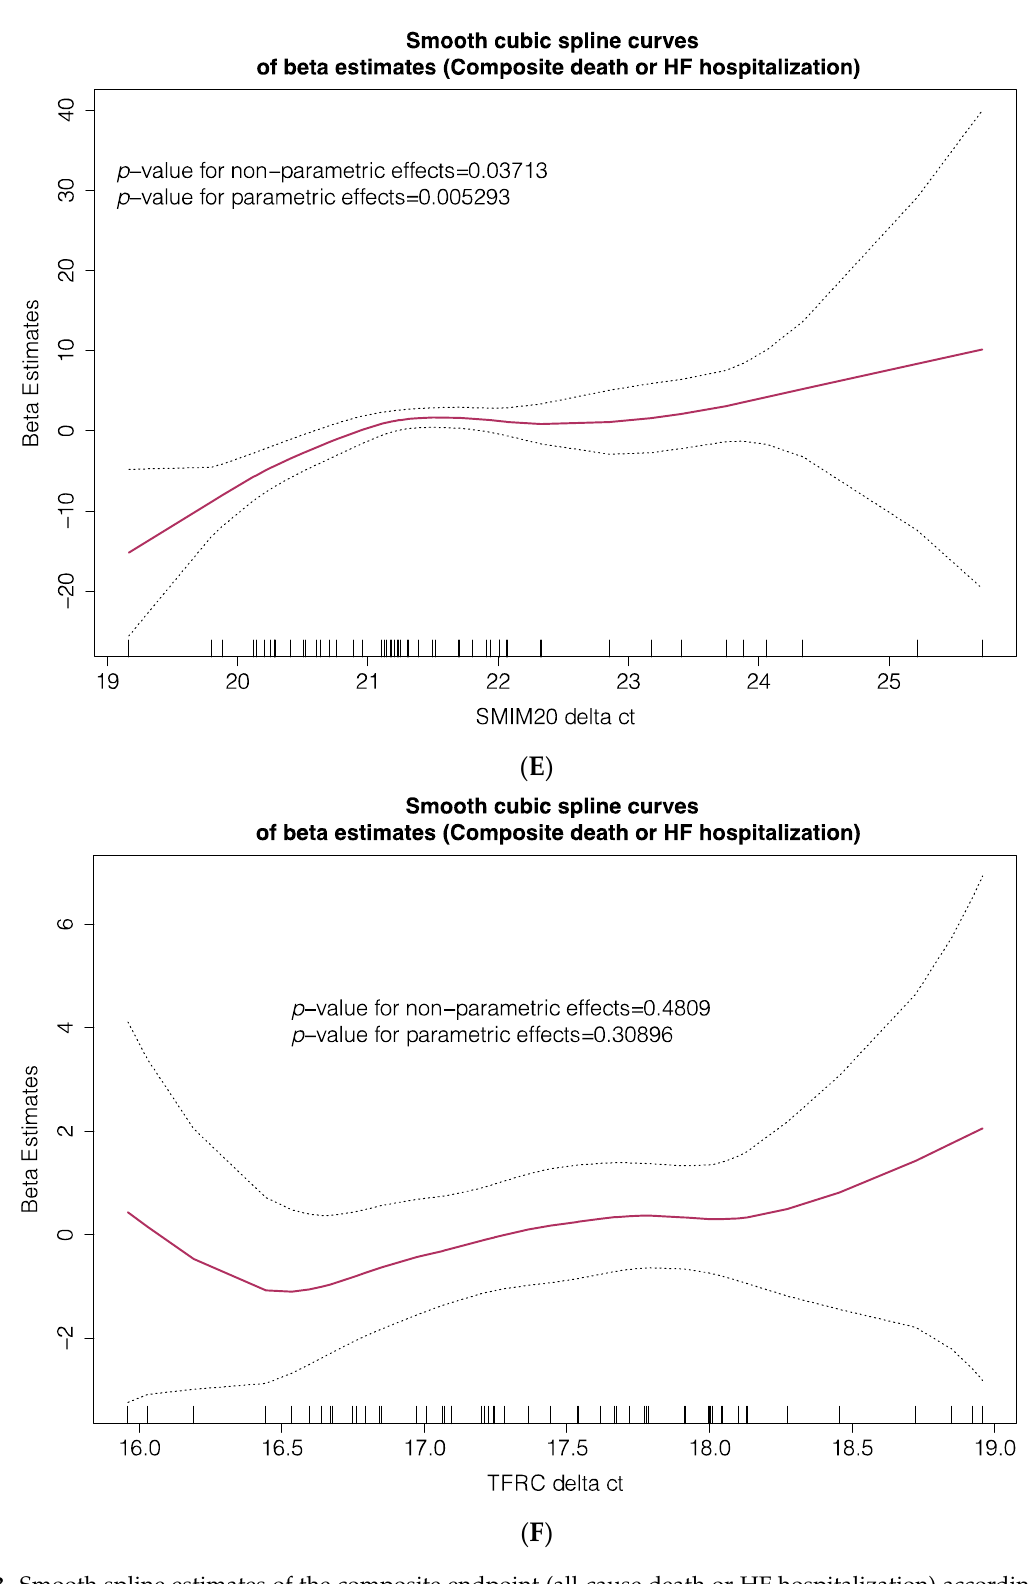
Figure 3. Smooth spline estimates of the composite endpoint (all-cause death or HF hospitalization) according to gene expression of ADM ( A ), ECE1 ( B ), FTMT ( C ), SIRT7 ( D ), SMIM20 ( E ) and TFRC ( F ). Δct: change in gene expression cycle threshold). Ct levels are inversely proportional to the amount of target nucleic acid in the sample (i.e., the lower the Ct level the greater the amount of target nucleic acid in the sample). Plots show the beta estimates of the outcome.